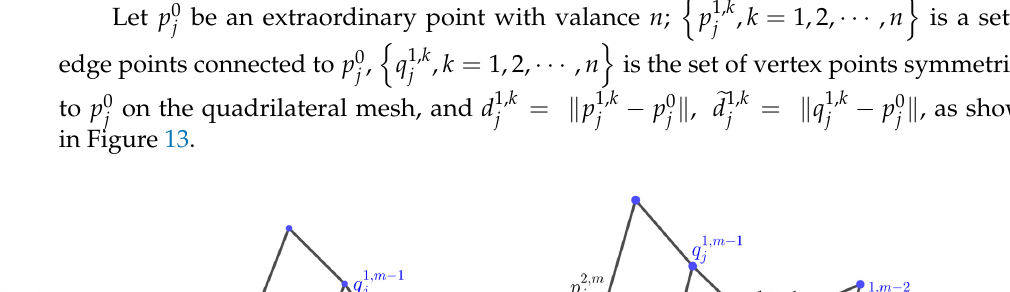
Figure 13. Notations for the construction of virtual points at an extraordinary point.